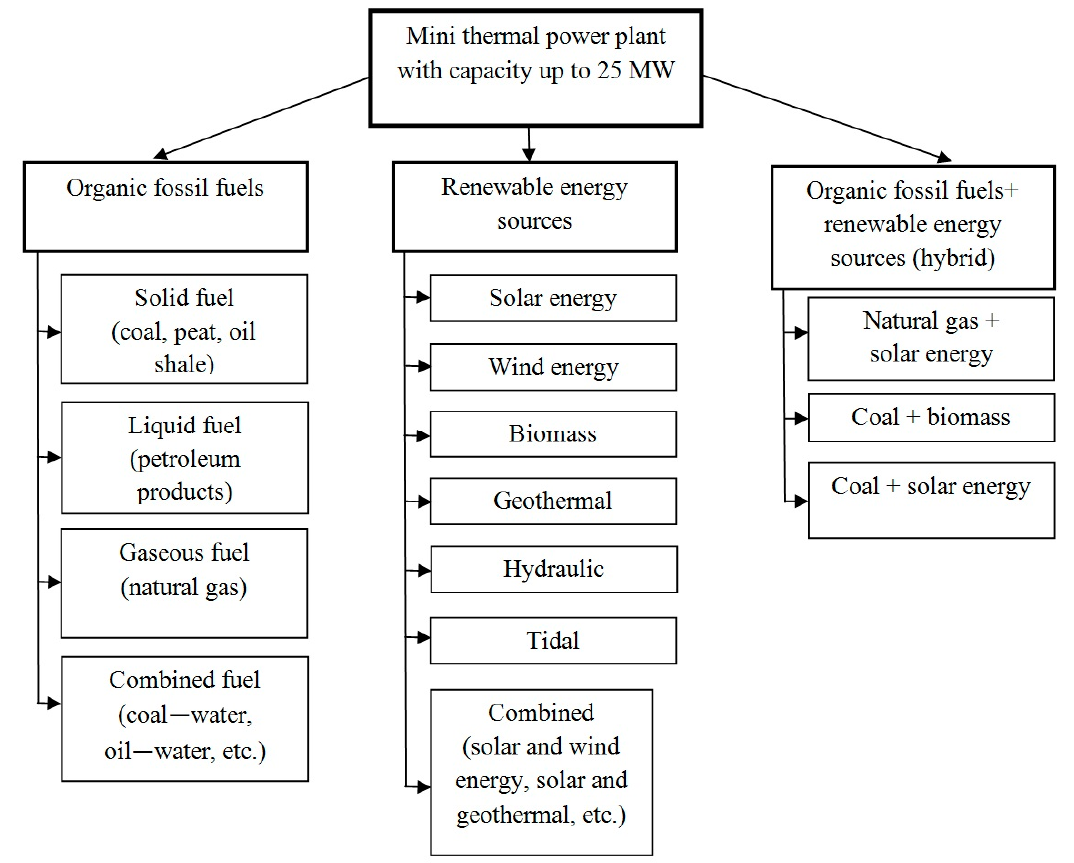
Figure 1. The classification of mini thermal power plants by the type of primary energy resources.